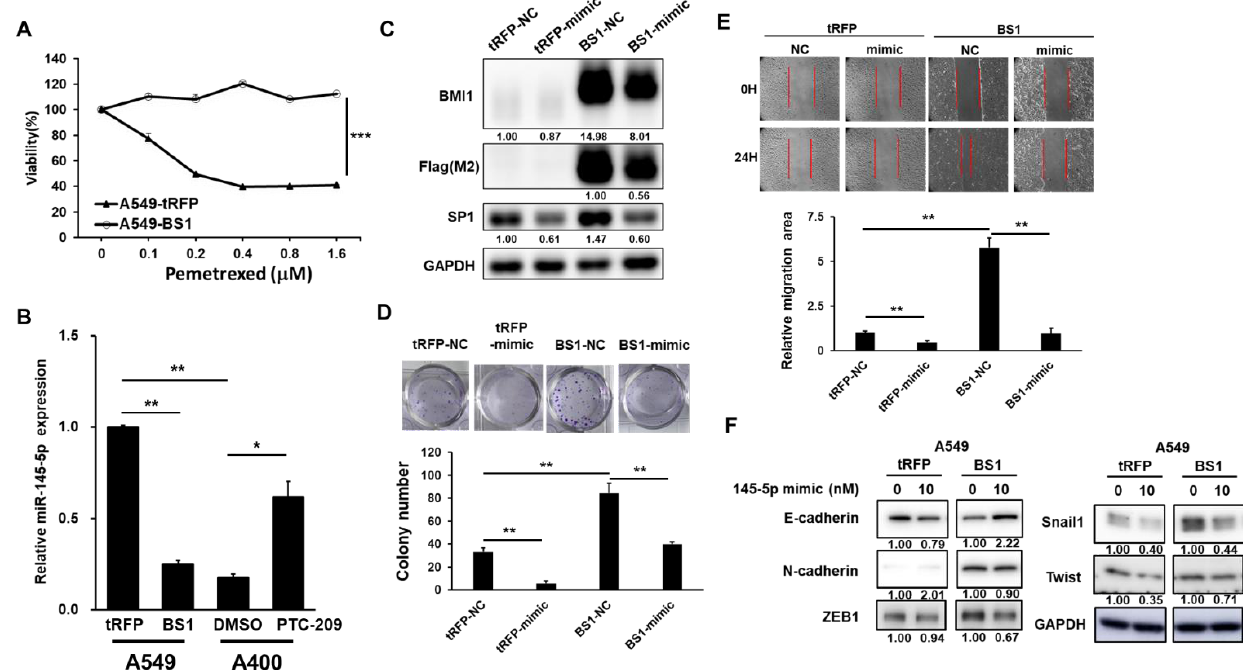
Figure 4. miR-145-5p suppresses BMI1-induced malignant phenotypes in A549 cells. BMI1 overex- pressed A549 cells (A549-BS1) or tRFP expressing A549 cells (A549-tRFP) were established as per our previous report [13]. ( A ) Pemetrexed sensitivity was measured by the MTT assay. ( B ) Expressions of miR-145-5p in the A549 or A549-BS1 cells were determined by the RT-qPCR method. A400 cells were treated with 5 µ M of PTC-209 for 48 h followed by the detection of miR-145-5p by RT-qPCR. ( C ) The expressions of BMI1, Sp1, or flag-tagged proteins were determined by Western blotting. ( D , E ) A549 or and harvested cells to determine the cell proliferation capability by the clonogenic assay ( D ) or cell migration activity by the wound healing assay ( E ). Red lines indicated the forefront of cell migration. ( F ) A549-tRFP or A549-BS1 cells were transfected with the 10 nM miR- 145-5p mimic or negative control mimic (NC, indicated as 0) for 48 h. The protein expressions of E-